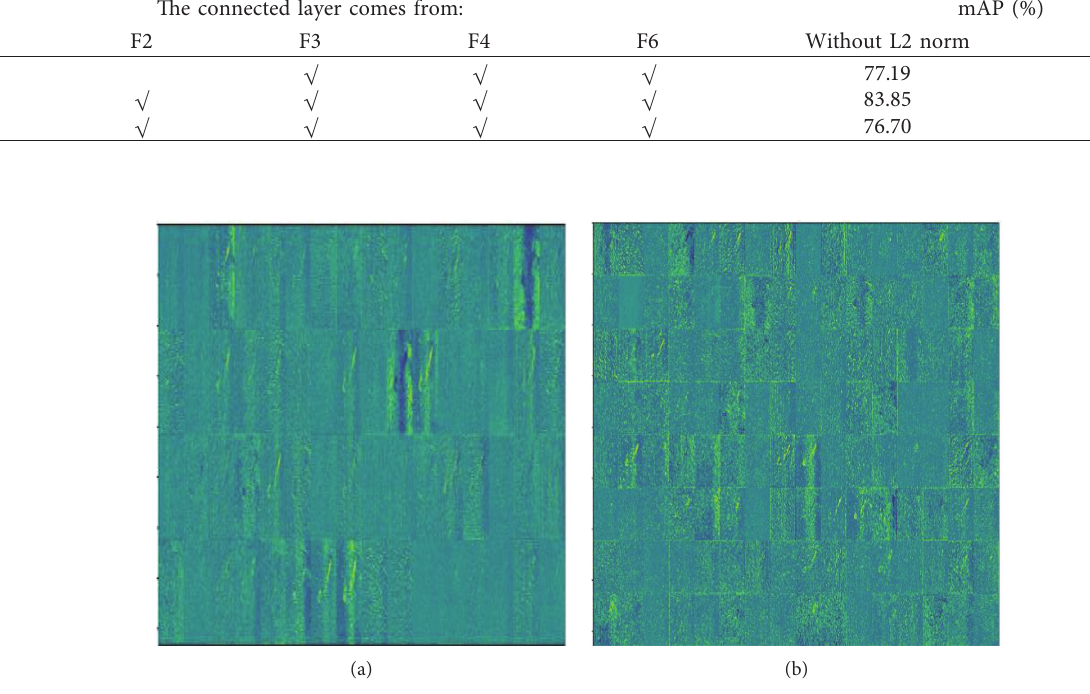
Figure 12: Feature layer visualization. (a) F1 feature map. (b) F2 feature